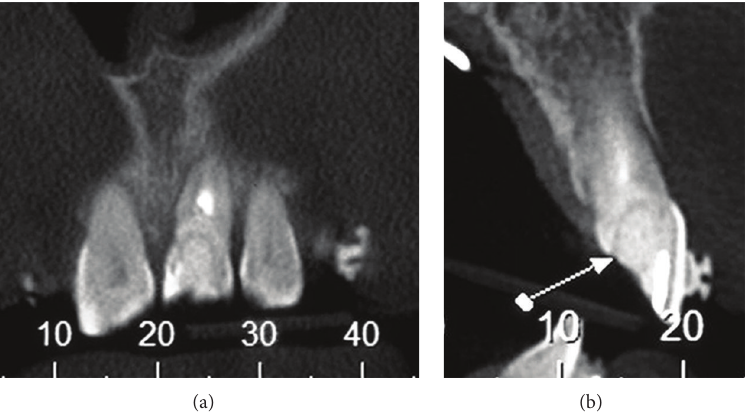
Figure 3: Computerized tomography showing the fracture line.